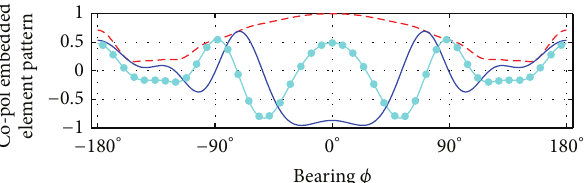
⃗𝑓 ( k ), ⃗𝑐⟩ of element zero, on 0 . The imp ⃗𝑓 ( k ), ⃗𝑐⟩ for 𝑛 = 0,...,𝑁 − 1 used in 𝑛 imp